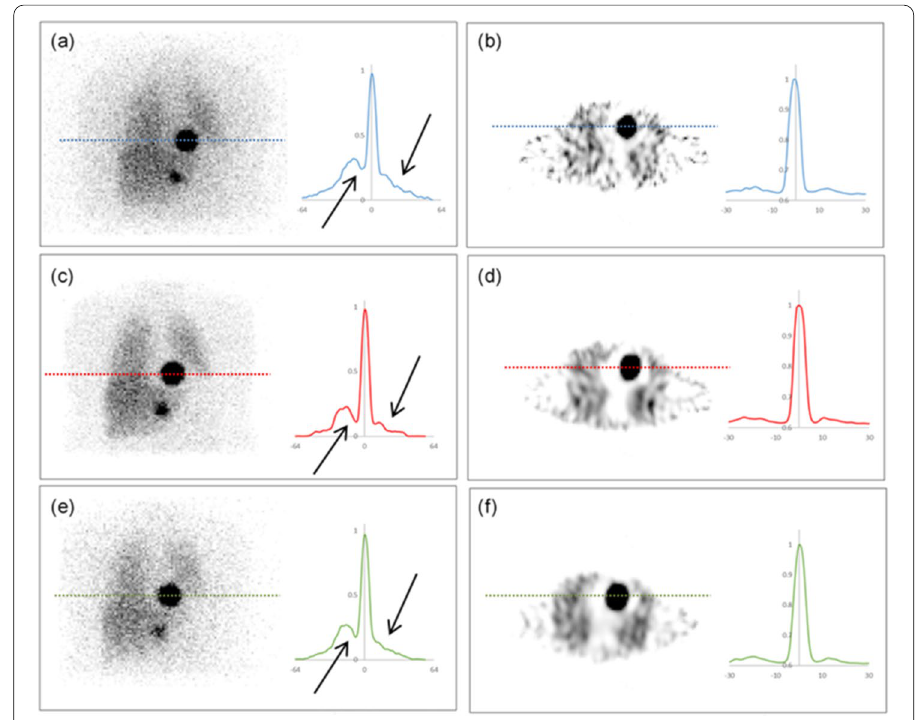
Fig. 7 Uncorrected projection images (a, c, e), and reconstructed corrected transaxial slices (b, d, f) through the voxel-based digital patient phantom for a , b 123 I LEHR, c , d 123 I ME and e , f 131 I HE. Profiles through the largest sphere are displayed alongside their respective images. Arrows indicate septal scatter and penetration at peak and trough and at tail